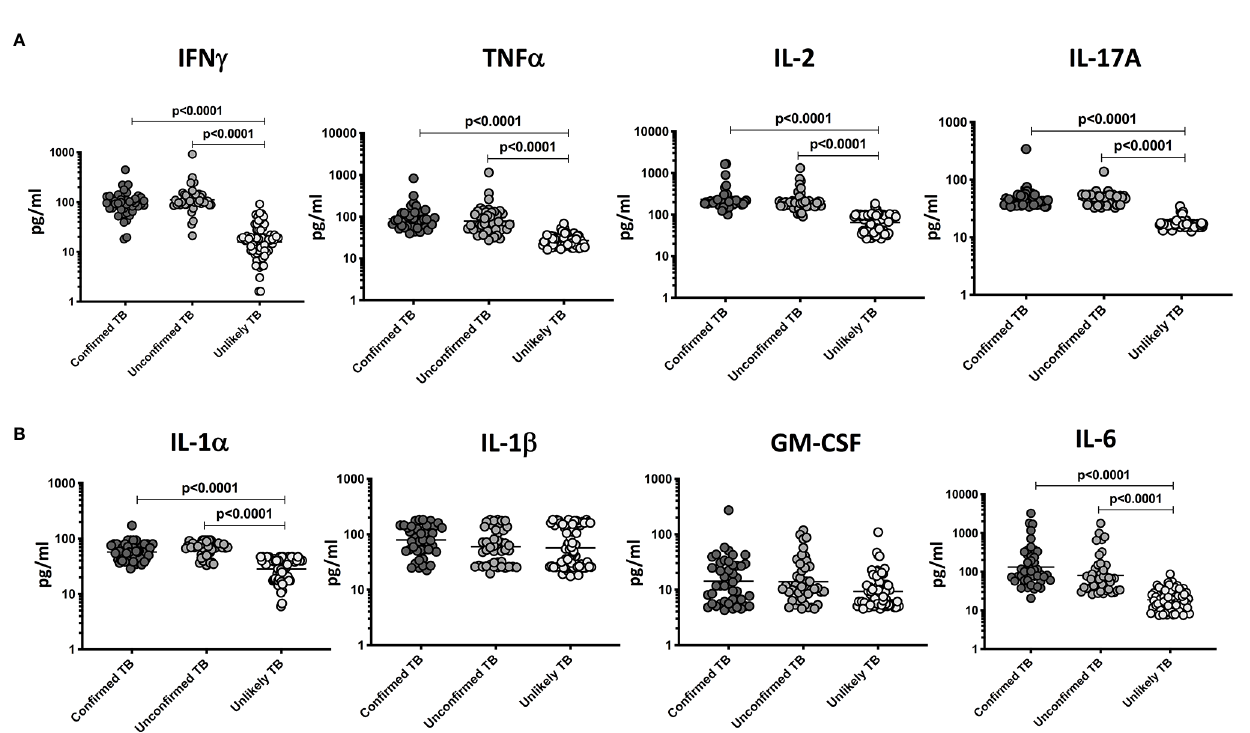
FIGURE 2 | Elevated circulating levels of Type 1, Type 17 and other pro-in fl ammatory cytokines in children with con fi rmed and uncon fi rmed TB disease – Discovery cohort. (A) The plasma levels of IFN g , TNF a , IL-2, and IL-17A and (B) IL-1 a , IL-1 b , GM-CSF, and IL-6 were measured in con fi rmed TB (n=44), uncon fi rmed TB (n=47) and unlikely TB (n=76) individuals at baseline. The data are represented as scatter plots with each circle representing a single individual. P values were calculated using the Kruskal-Wallis test with Dunn ’ s post-hoc for multiple